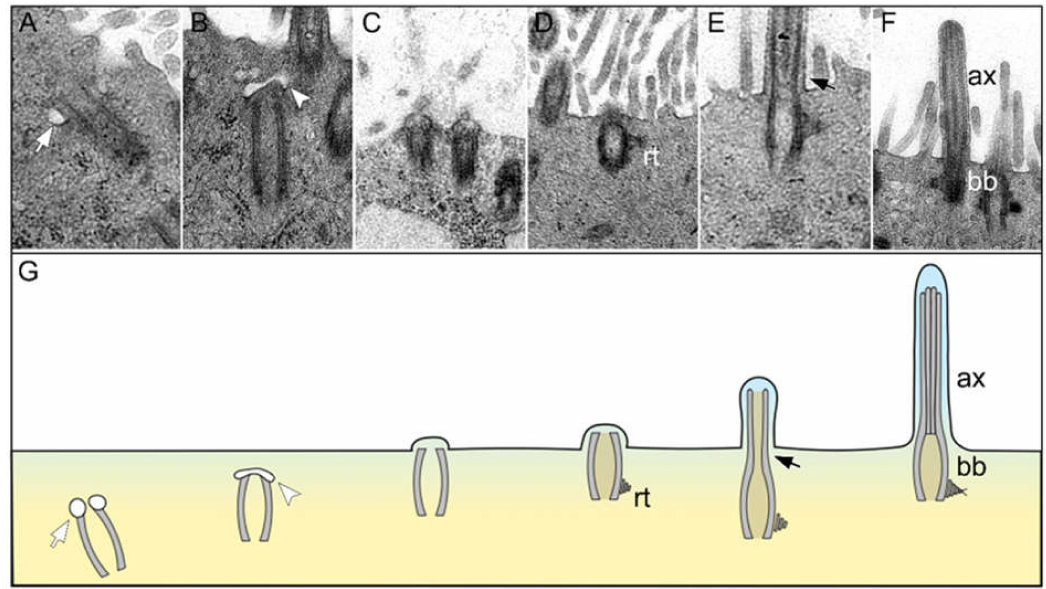
Figure 4. Ciliary regeneration in the trachea of a hamster 6 days after SARS-CoV-2 infection. ( A – G ) Representative transmission electron micrographs showing different stages of ciliary regener- ation and a schematic illustration of the sequence of ciliary regeneration. ( A ) The centriole starts to produce a primary cilium by forming vesicles at the distal end (white arrows in ( A , G )). ( B ) A ciliary bud develops at the distal end of the centriole invaginating the ciliary vesicle (white arrowheads in ( B , G )). ( C ) The ciliary bud migrates to the apical pole of the cell and bulges the cell membrane. ( D ) The basal body develops a lateral rootlet (rt in ( D , G )). ( E ) The organelle elongates apically and forms the axoneme (black arrows in ( E , G )). ( F ) Mature cilia with regularly formed axoneme (ax in ( F , G )) and basal body (bb in ( F , G )). Magnifications are 31,500 × in ( A ), 40,000 × in ( B ), 10,000 × in ( C , D ) and 12,500 × in ( E , F